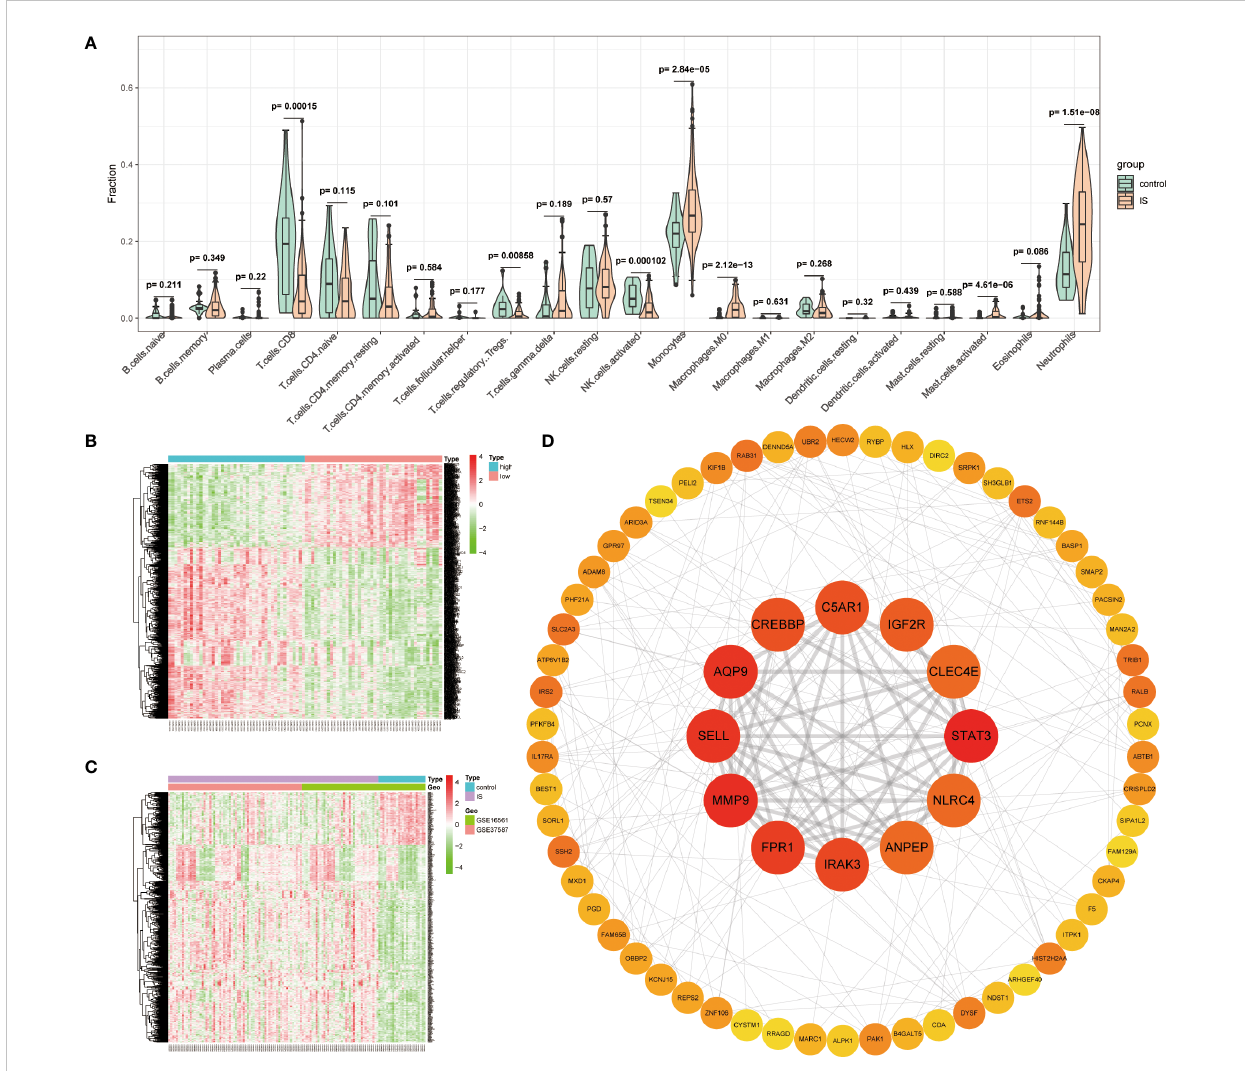
FIGURE 4 Identi fi cation of IS-speci fi c neutrophil-related genes (ISNGS) and selection of the candidate critical genes. (A) Violin plot showing the difference in the in fi ltration proportion of 22 immune cells between IS patients and controls. (B) Heatmap displaying different gene expression patterns between neutrophil-high and neutrophil-low groups. (C) Heatmap displaying different gene expression patterns between IS and control groups. (D) The constructed PPI network ascertaining candidate critical genes by degree